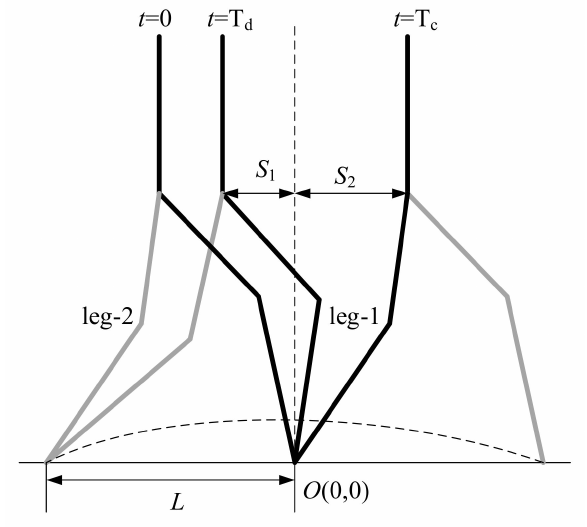
Figure 2. Walking cycle including double support phase (DSP) and single support phase (SSP). Origin of world frame is at the stance ankle. L is the step length, and S 1 and S 2 are the hip horizontal positions at the beginning and at the end of SSP, respectively.